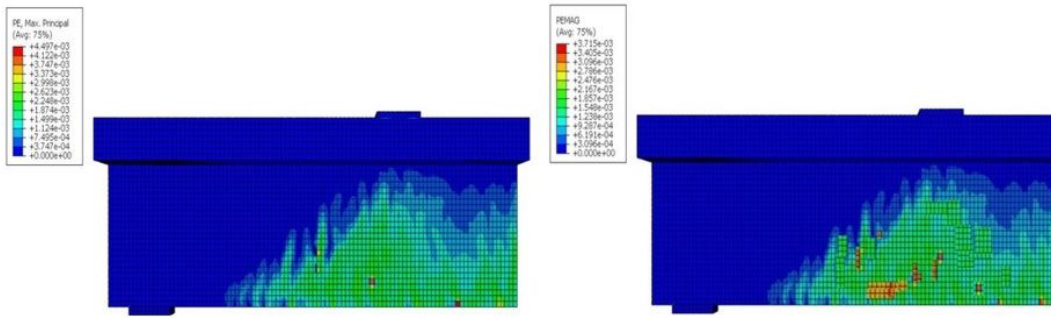
Figure 20: The numerical crack patterns of the specimens PB1 (left) and PB2 (right)